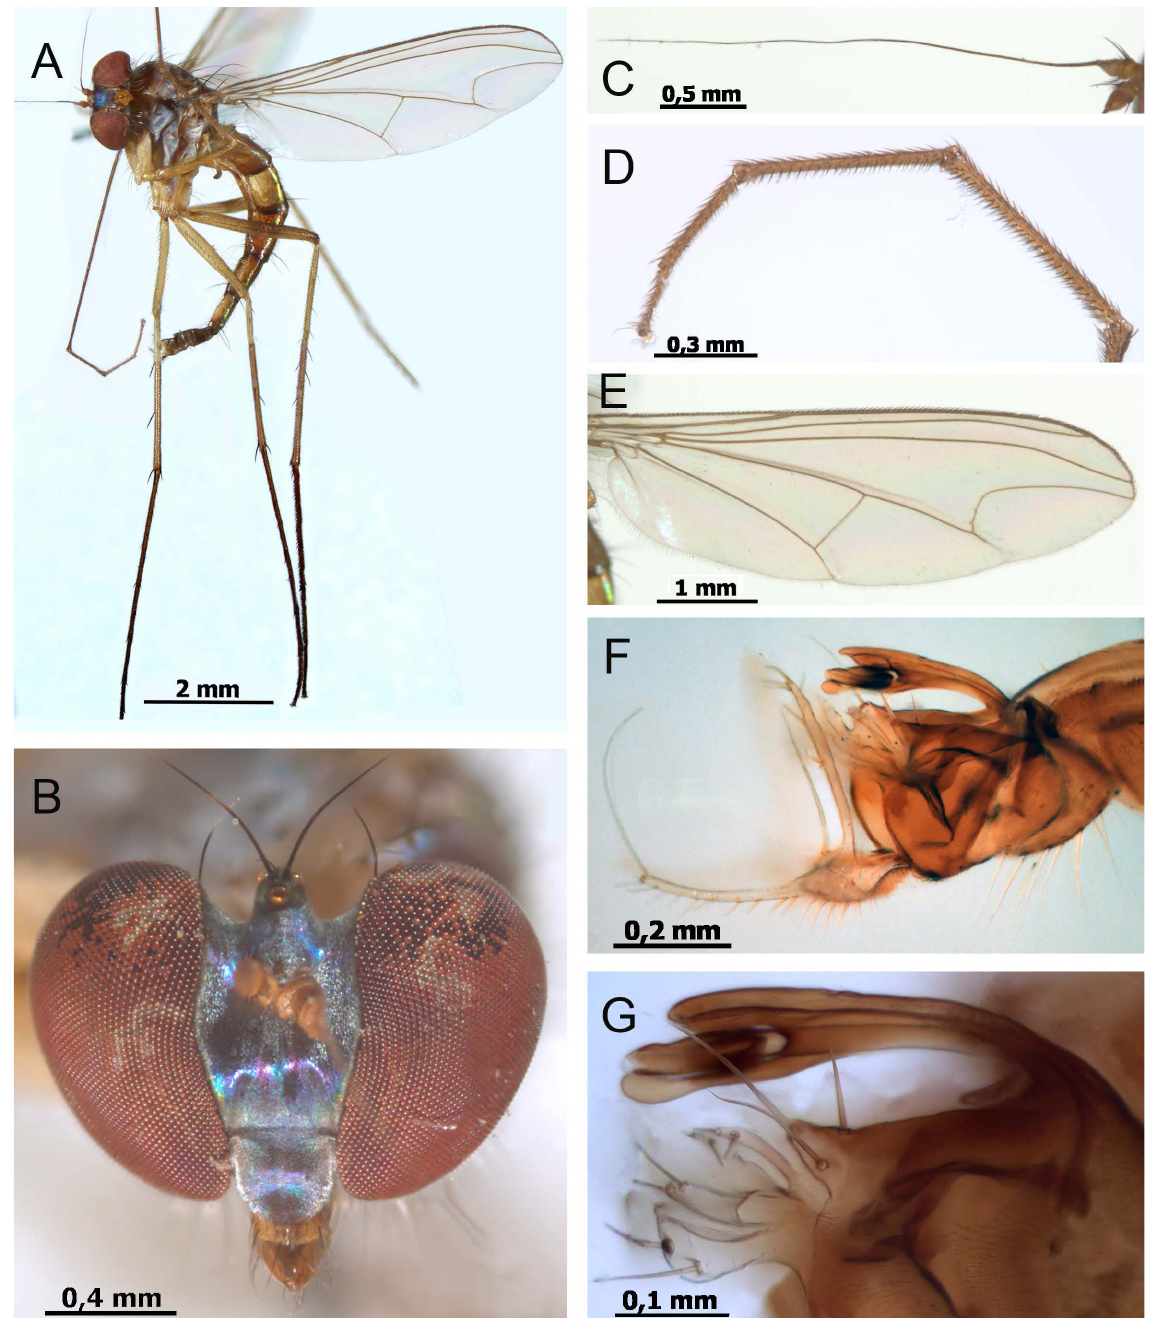
Fig. 4. Amblypsilopus friedmani sp. nov. A–E . Holotype, ♂ (SMNHTAU). F–G . Paratype, ♂ (SMNHTAU). A . Habitus. B . Head. C . Antenna. D . Fore tarsomeres 2–5. E . Wing. F . Hypopygium, left lateral view, reflected light. G . Distoventral appendages of hypopygium, transmitted